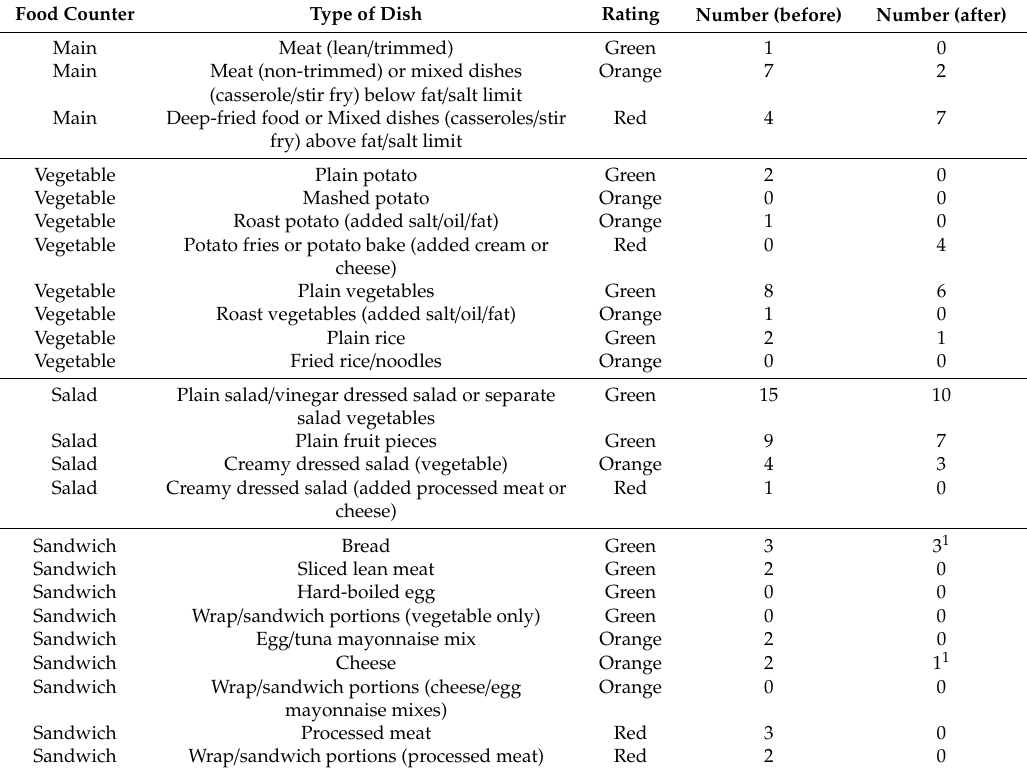
Table A2. Summary of healthfulness classifications of dishes made available at dinner. Food Counter Type of